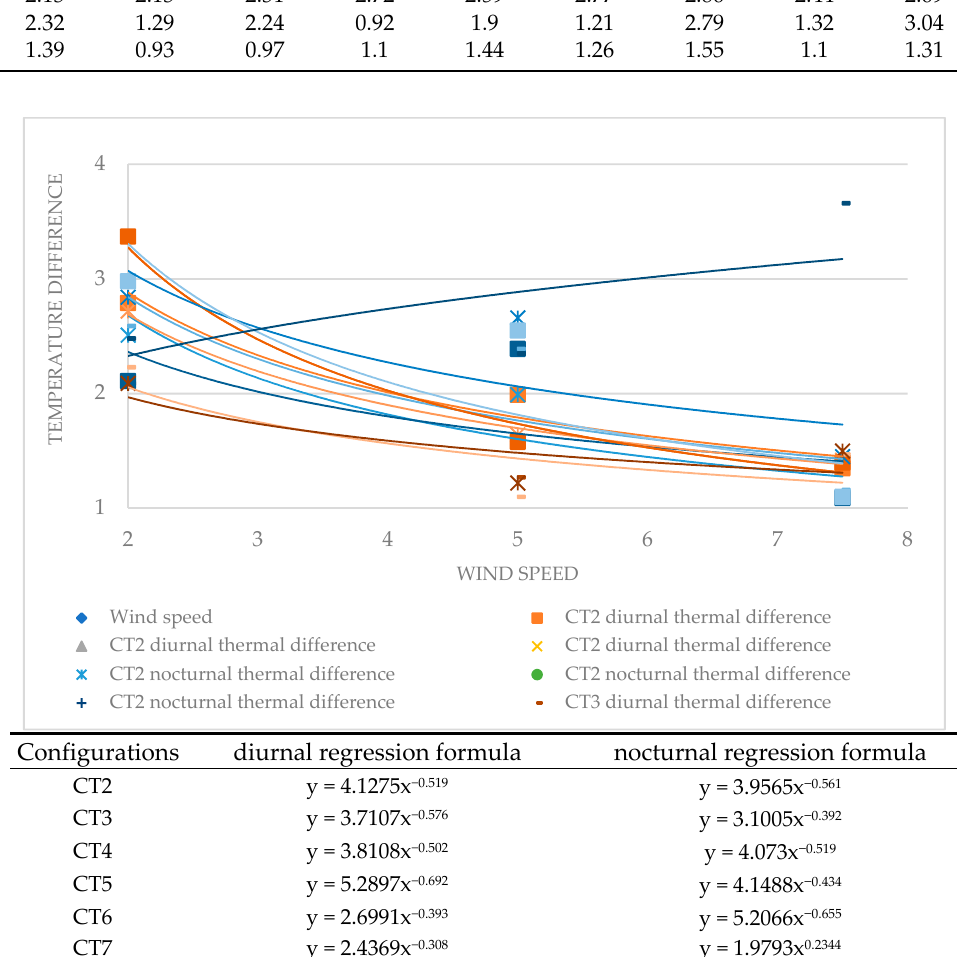
Figure 9. Correlation between the wind speed on the horizontal axis and maximum diurnal, nocturnal ambient air temperature difference on the vertical axis in Compact Types configurations with their associated regression function formula for diurnal and nocturnal. Analysis of the diurnal/nocturnal regression formula that correlates wind speed and temperature decrease along the compact type arrangements predicted the maximum diurnal temperature decrease along the CT5 arrangement with the equation of y = 5.2897x − 0.692 and minimu m of y = 2.4369x − 0.308 in CT7 when the wind speed value on these three days. The nocturnal regression formula indicates a decline in temperature decrease in CT7 with the equation of y = 1.9793x 0.2344 while the CT6 predicted the maximum temperature decrease with the equation of y = 5.2066x − 0.655 . In open-type arrangments, the diurnal temperature difference ranged from 3.78 °C in OT2 on 17th January to 0.93 °C in 0T3 on 19th February. Table 16 present a summary of the wind speed and ambient air temperature difference in open arrangements. Similar results compare to compact type arrangements derived from analysis of the data in Table 15 and Figure 9. Table 16. Wind speed and diurnal (1) and nocturnal (2) temperature difference in open-type ar- rangements.